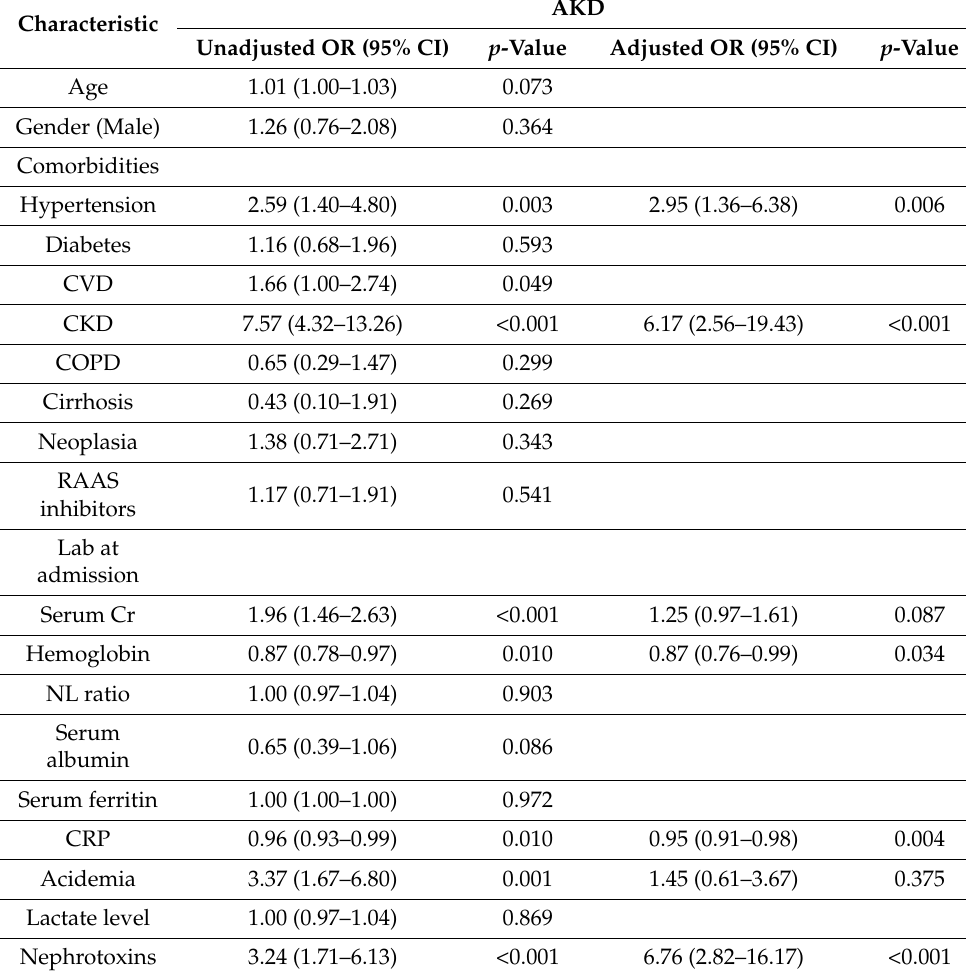
Table 2. Univariate and multivariate analysis of factors predictive of AKD in COVID-19